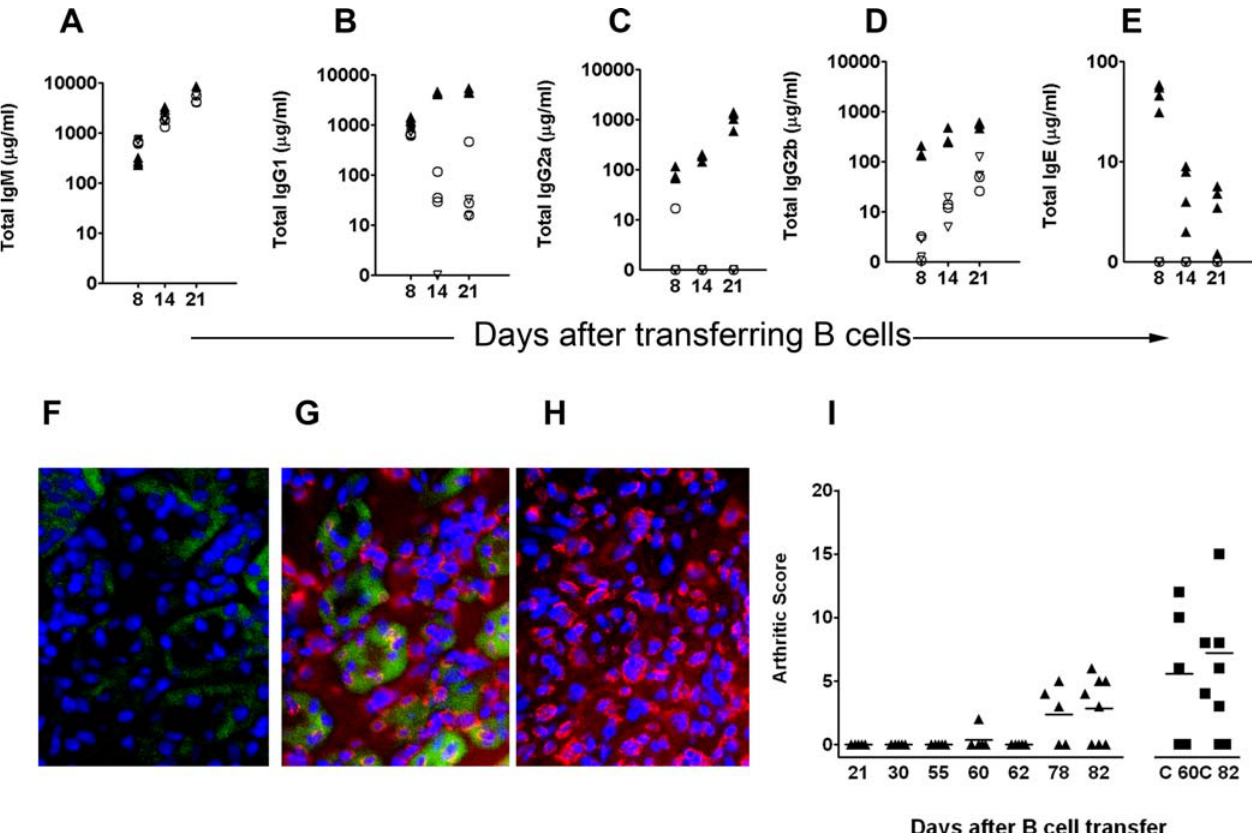
Figure 4. Stable Adaptive Tolerance Does Not Abrogate the Ability of T Cells to Help Autoreactive B Cells (A–E) Purified splenic B cells (25 million) were transferred into mPCC,Rag2 (cid:1) / (cid:1) mice that received 5C.C7 T cells 48 d earlier. The amount of serum antibody of each isotype 8, 14, and 21 d after the transfer of PCC transgenic B cells (triangles) or antigen-free B cells (circles) is plotted. Solid triangles and open circles are measurements from mice that received 5C.C7 T cells 48 d before the B-cell transfer. Open inverted triangles are measurements from mPCC,Rag2 (cid:1) / (cid:1) mice that did not receive T cells. Two other experiments, including one using FACS-sorted B cells, showed similar results. (F–H) Antinuclear antibodies in the serum of mPCC,Rag2 (cid:1) / (cid:1) mice 30 d after B-cell transfer (H). Three other mice from the same experiment also showed anticellular reactivity. Similarly stained tester sections using serum from an mPCC,CD3 e (cid:1) / (cid:1) mouse that received 5C.C7 T cells 60 d earlier (G) or a control B10.A mouse (F) are provided for comparison. (I) Arthritis development between 21 and 82 d after the transfer of mPCC þ B cells (triangles) into mPCC,Rag2 (cid:1) / (cid:1) mice bearing adoptively tolerant 5C.C7 T cells. Arthritis in mPCC,CD3 e (cid:1) / (cid:1) mice 60 and 82 d after receiving naive 5C.C7 T cells (squares: C 60, C 82) are scored for comparison. DOI: 10.1371/journal.pbio.0040340.g004